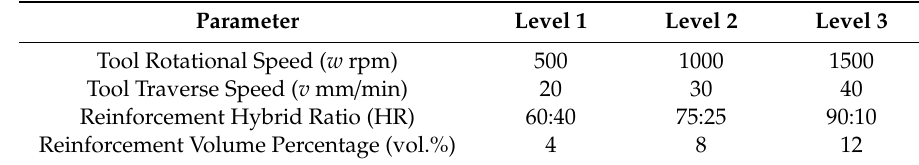
Table 1. Independent parameters and their